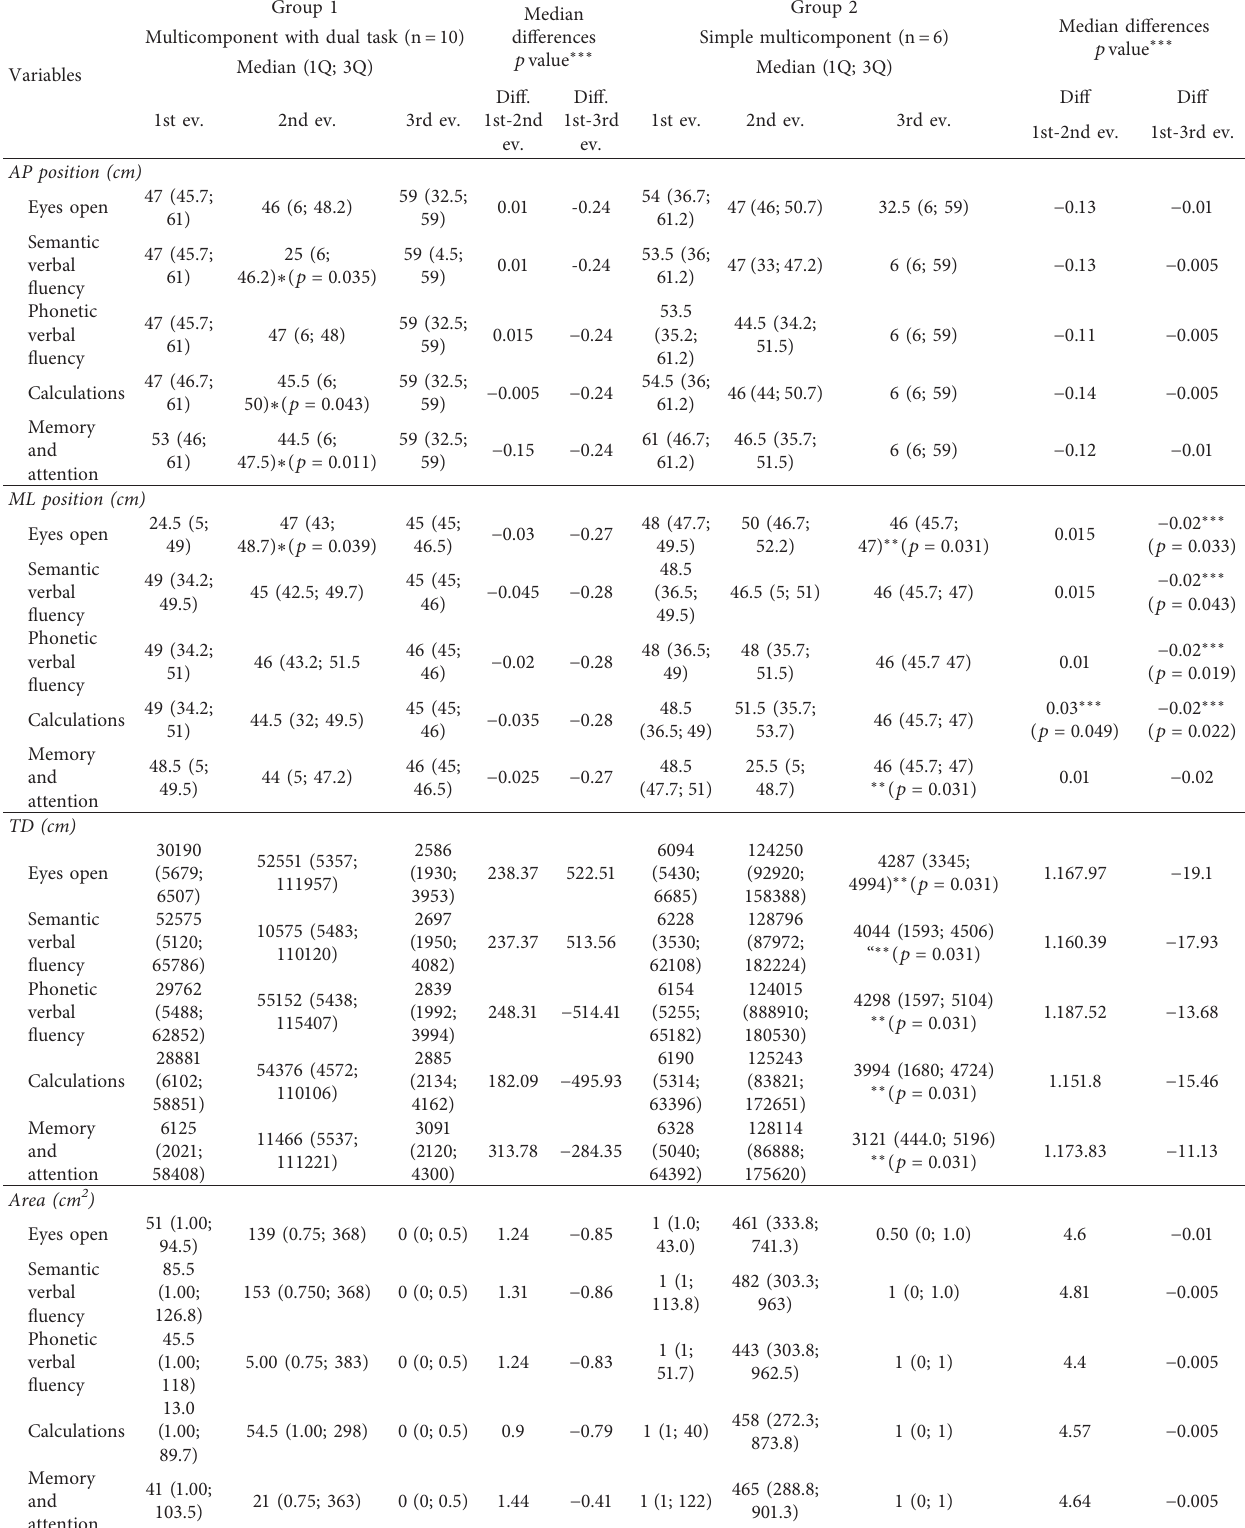
Table 5: Posturographic variations between the first, second, and third